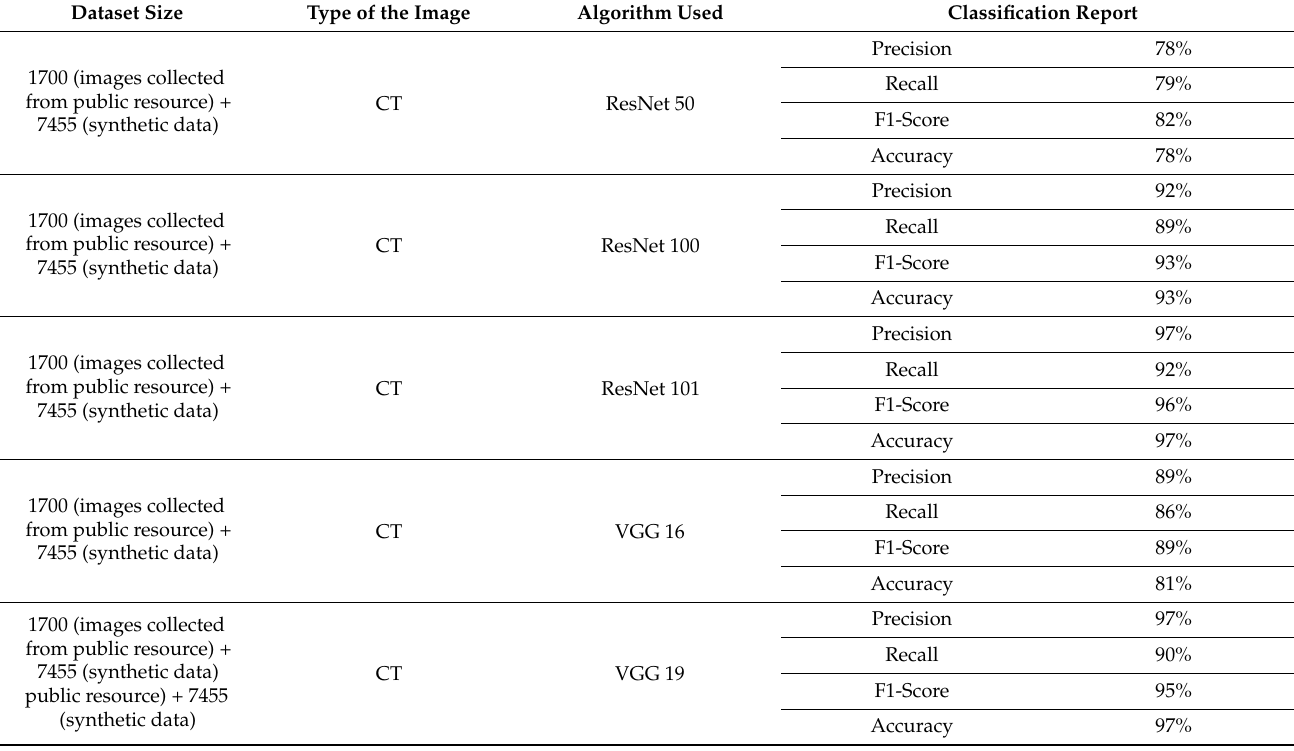
Table 3. Performance analysis of deep convolution neural network architectures on CT images.